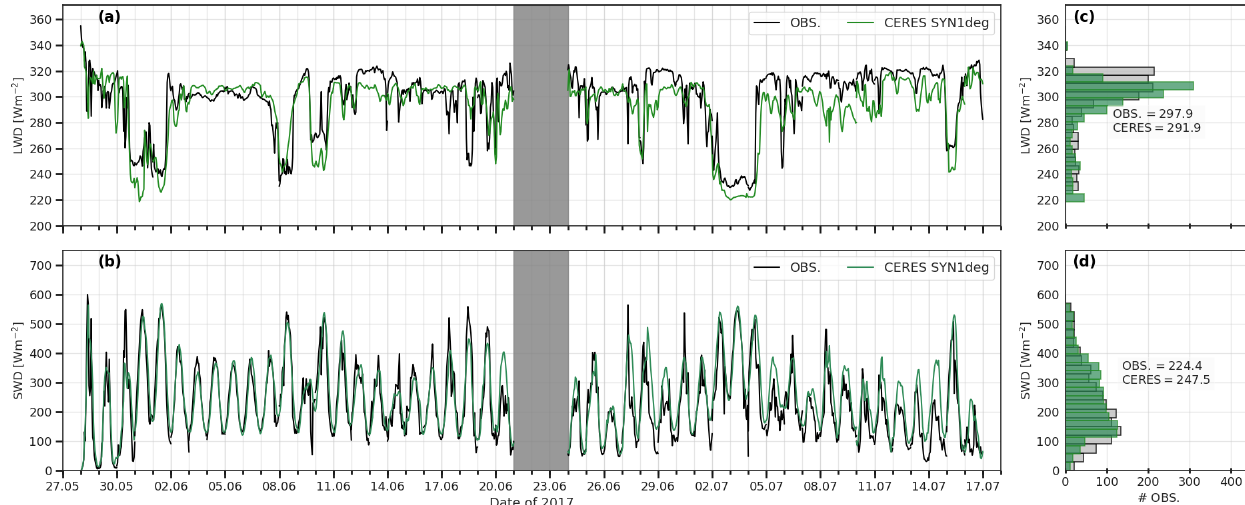
Figure 13. Time series during PS106 of downward LW (LWD; panel a ) and downward SW (SWD; panel b ) fluxes. In panels (a) and (b) , observations are shown in solid black lines, CERES SYN1deg AS products in the solid green line. The distribution of each time series is shown in panels (c) and (d) .